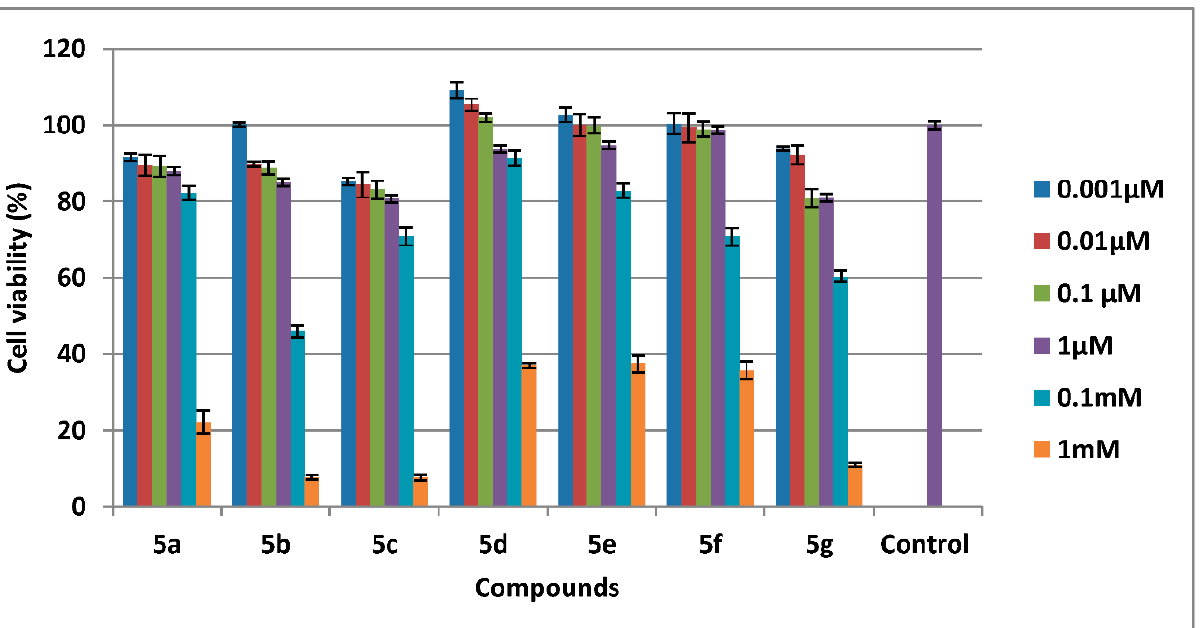
Table 2. Light micrographs of L929 fibroblast cells, untreated (Control), and treated with pyrazolo- benzimidazole hybrid derivative solution in a range of 0.001 μ M–1 mM concentration. Control